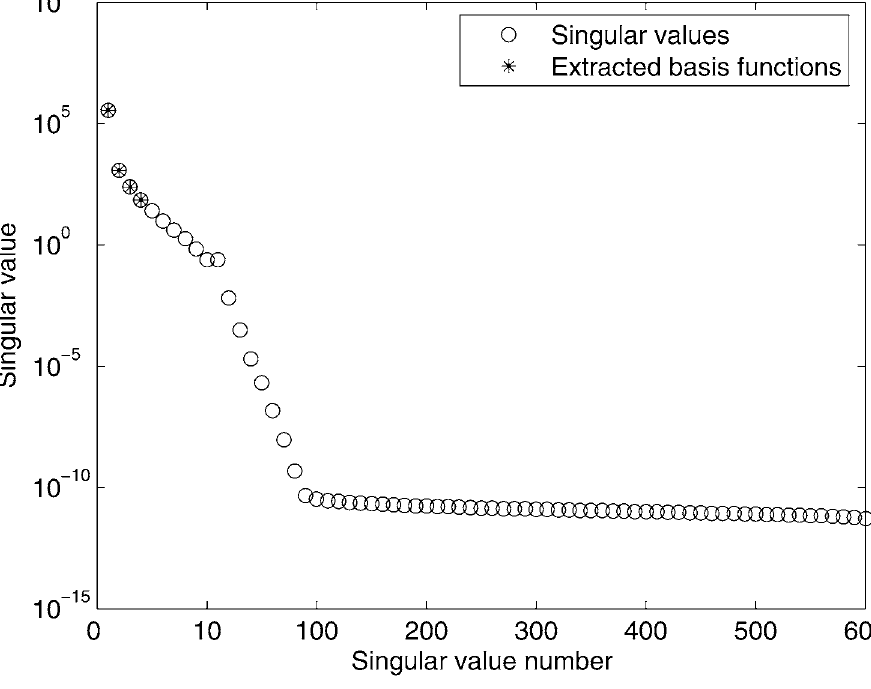
Figure 2. Singular values of the snapshot matrix. The *’s indicate singular values corresponding totheextractedbasisfunctions.Notethattheordinateaxisislogarithmic.Fromsingularvalue10–600, every tenth singular value is plotted, for